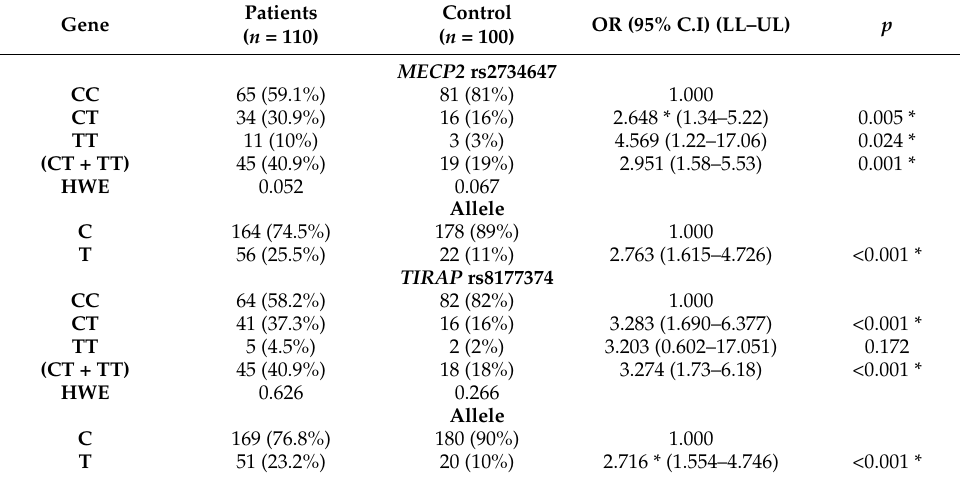
Table 2. Comparison between the two studied groups according to MECP2 rs2734647 and